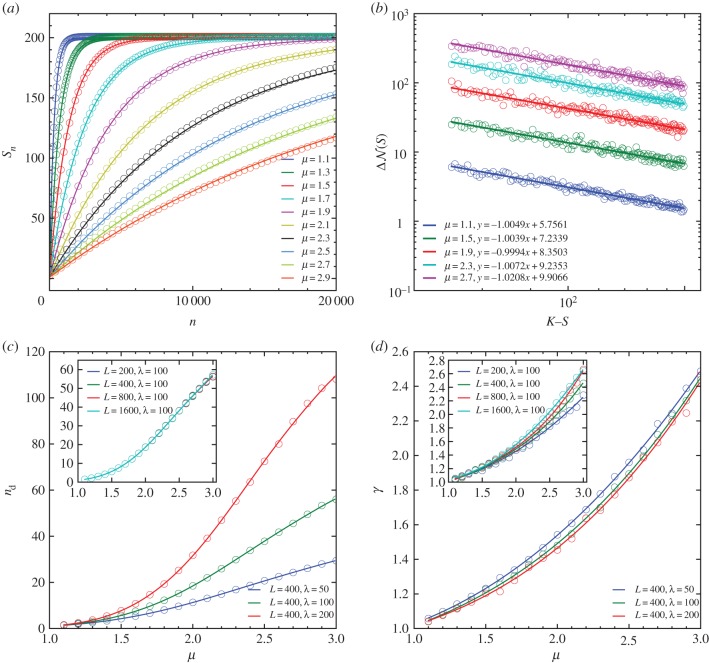
(a) The number of discovered targets Sn versus step number n. The curves in different colours from top to bottom correspond to various μ ∈ [1.1, 2.5] with an interval of 0.2. Here, we use the landscape size L = 200 and the number of targets K = 200. The dots represent simulation results averaged for 100 realizations, and the solid lines represent the corresponding mean-field solution given by equation (3.3). (b) The mean number of steps between the discovery of the Sth target and the (S + 1)th target  versus the number of undiscovered targets K − S. The dots represent simulation results, and the lines represent the corresponding linear regression fit. (c) The mean number of steps between two consecutive detections nd as a function of μ for different values of L and K. Here, K is adjusted to obtain the corresponding λ given L. The solid lines represent the nonlinear fitting . (d) The constant coefficient γ as a function of μ for different values of L and K. The solid lines represent the cubic polynomial fitting.